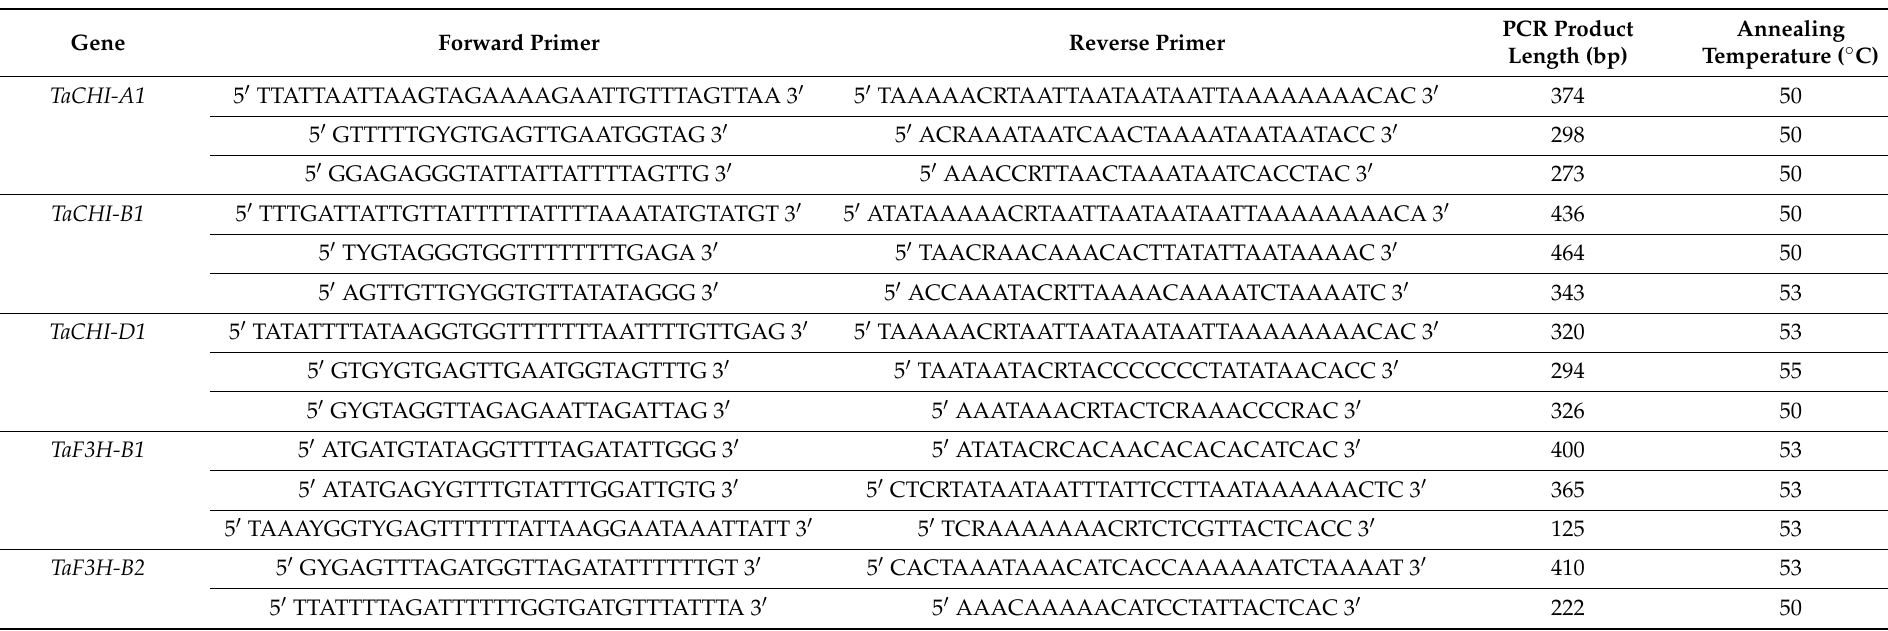
Table 1. Gene-specific primers used for amplification of the TaCHI and TaF3H genes in the present study. R—purine (A, G), Y—pyrimidine (C,